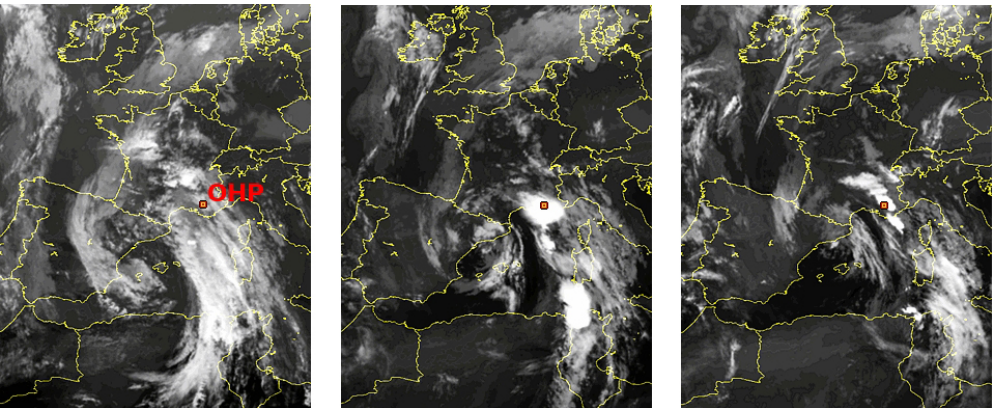
Figure 6. Satellite image of western Mediterranean Basin on 21 and 22 October 2012, at 14:00, 21:00 and 04:00UTC, respectively. Data are acquired by the geostationary meteorological satellite METEOSAT9, using the IR channel at 10.8µm. The colour scale, from black to white, is proportional to cloud top temperature. Colder cloud tops (generally associated with more vertically developed clouds) are brighter. The OHP station (5.7, 43.9 ◦ ) in southern France is indicated by a red-yellow